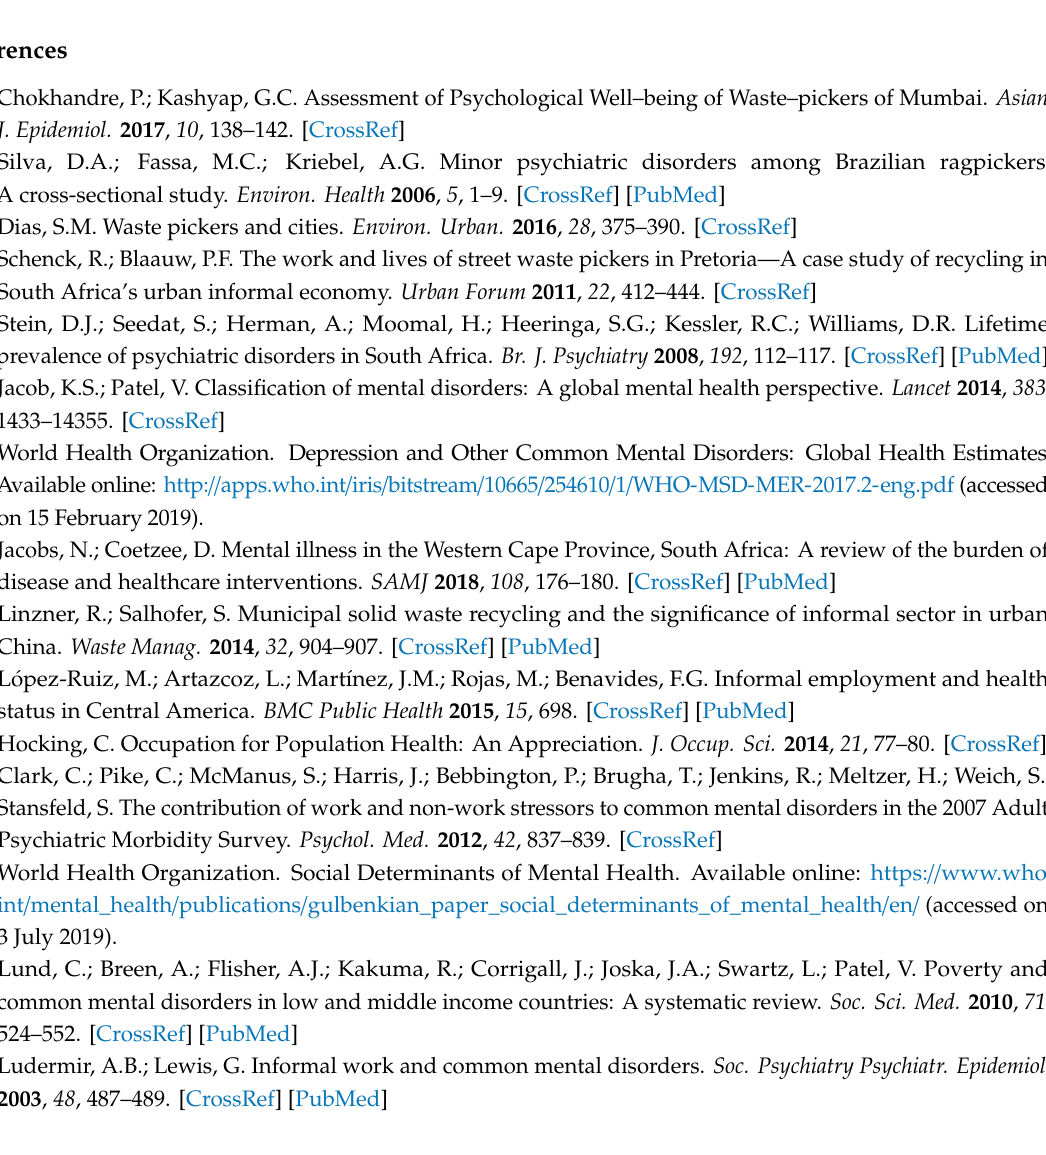
Table S1: Distribution of socio-demographic features of the waste pickers in Johannesburg; File S1: Primary study questionnaire: Occupational hazards and health access of waste pickers in Johannesburg, South